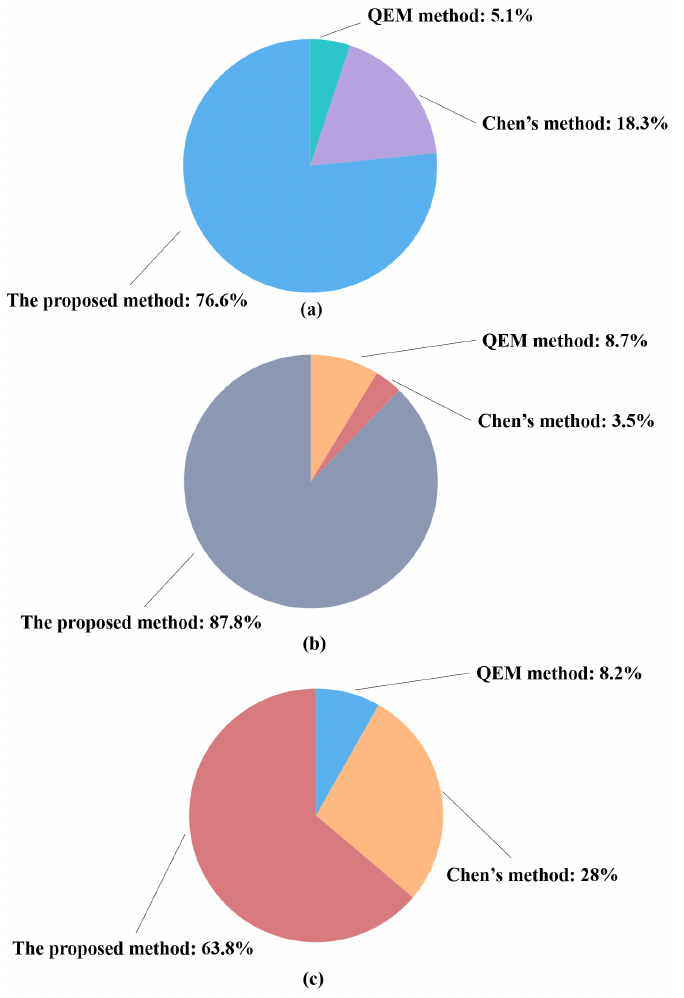
Figure 15. Results of the user study: ( a ) the pavilion; ( b ) the apartment; ( c ) the house.